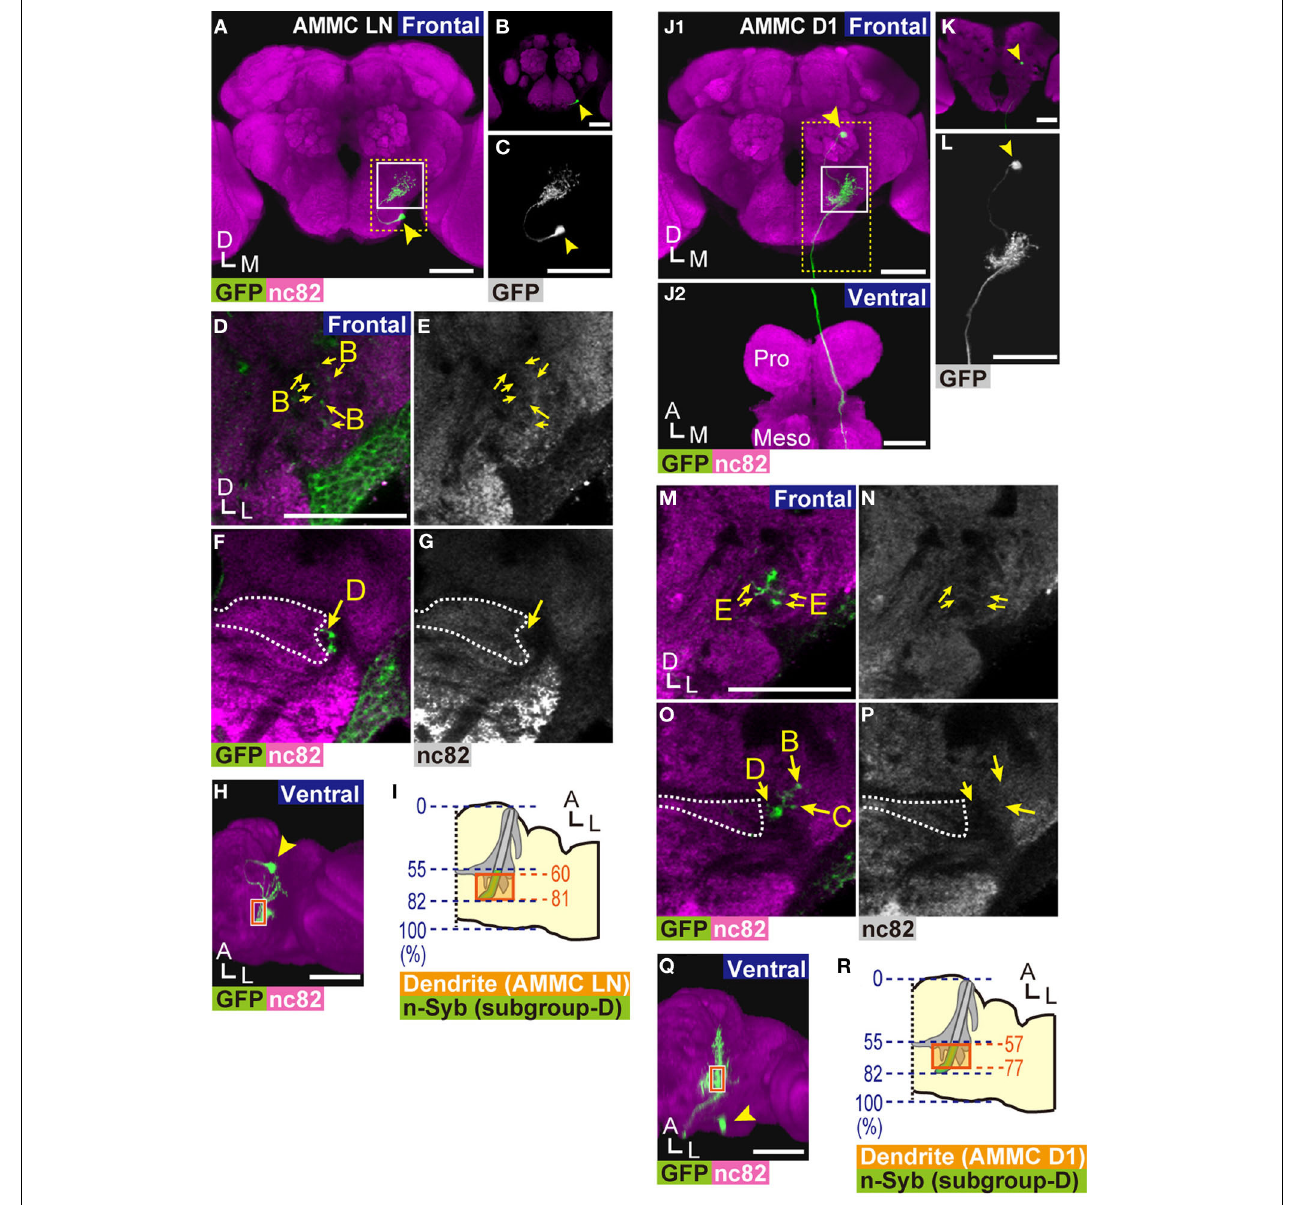
FIGURE 5 | Projection neurons innervating zone D. (A,B) 3D-reconstructed frontal images of AMMC LNs in the brain. AMMC LNs cell bodies are located at the anterior side of the brain (B) . (C) Magnified view of an AMMC LN (yellow dotted box in panel A ). (D–G) Innervation pattern of an AMMC LN. Magnified view of the AMMC (white box in panel A ). AMMC LNs project to zones B (arrows in panels D,E ) and D (arrows in panels F,G ). (H,I) Distribution of dendritic regions of AMMC LNs. Ventral view of panel A (H) . Blue dotted lines indicate the length ratio along the anterior-posterior axis of the brain (I) . Presynaptic sites of subgroup-D JO neurons identified at Figure 1V are shown in green. Orange boxes in panels (H,I) show the area where dendrites of AMMC LNs were observed in zone D. (J,K) 3D-reconstructed images of AMMC D1 neurons. Arrowheads indicate the position of the cell body. Frontal view of the brain (J1) and ventral view of the ventral nerve cord (J2) are shown. The axon of an AMMC D1 neuron innervates the prothoracic ganglion (Pro) and mesothoracic ganglion (Meso). Cell bodies of AMMC D1 neurons are located at the posterior side of the brain (K) . (L) Magnified view of an AMMC D1 neuron